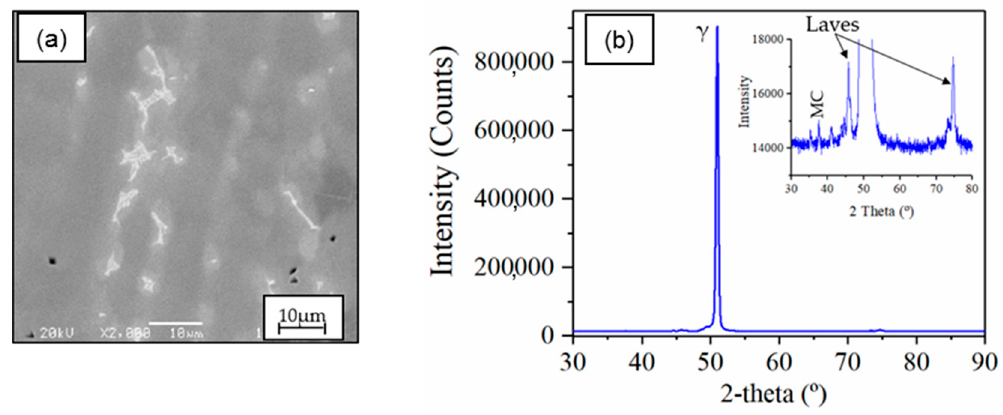
Figure 11. ( a ) the microstructure and corresponding ( b ) XRD pattern of WAAM IN718.